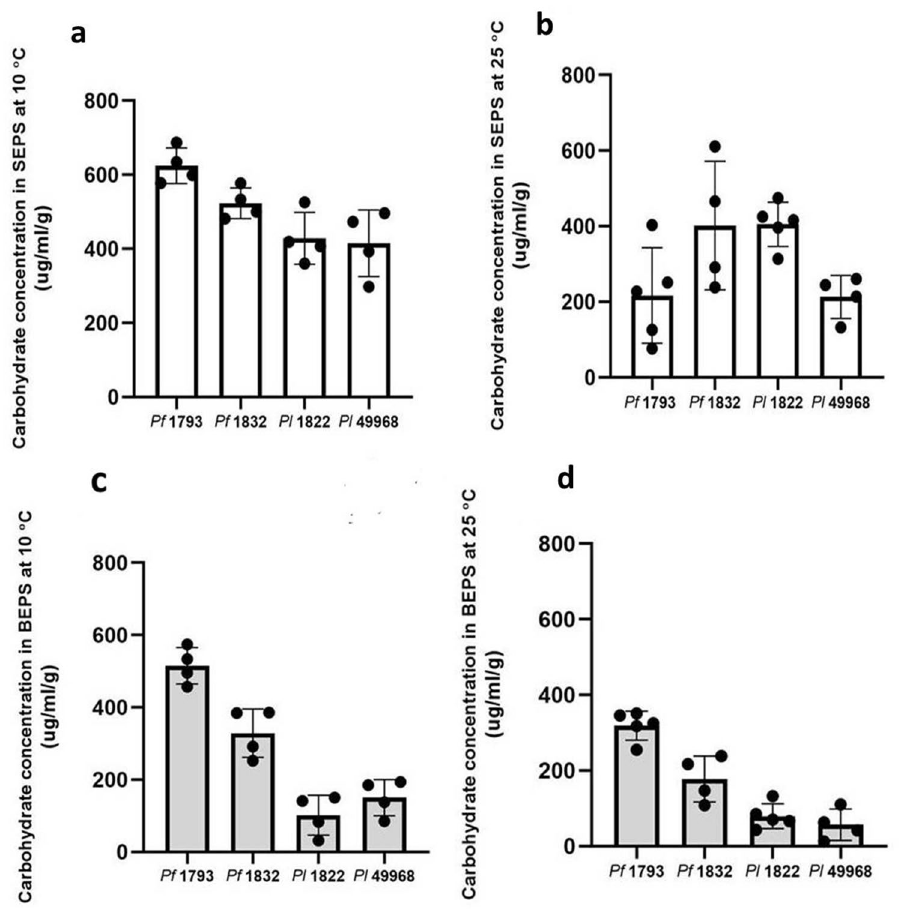
Figure 4. The carbohydrate content of the soluble and bound fractions of matrix EPS. The carbohydrate content of four biological replicates of P. fragi (1793, 1832) and P. lundensis (1822, ATCC 49968) biofilms formed on nitro-cellulose membrane placed on meat at 10 °C ( a , c ) and 25 °C ( b , d ). Error bars show the standard deviations from four biological replicates. Statistical differences were evaluated through one-way ANOVA, with a confidence level of 95% ( P <